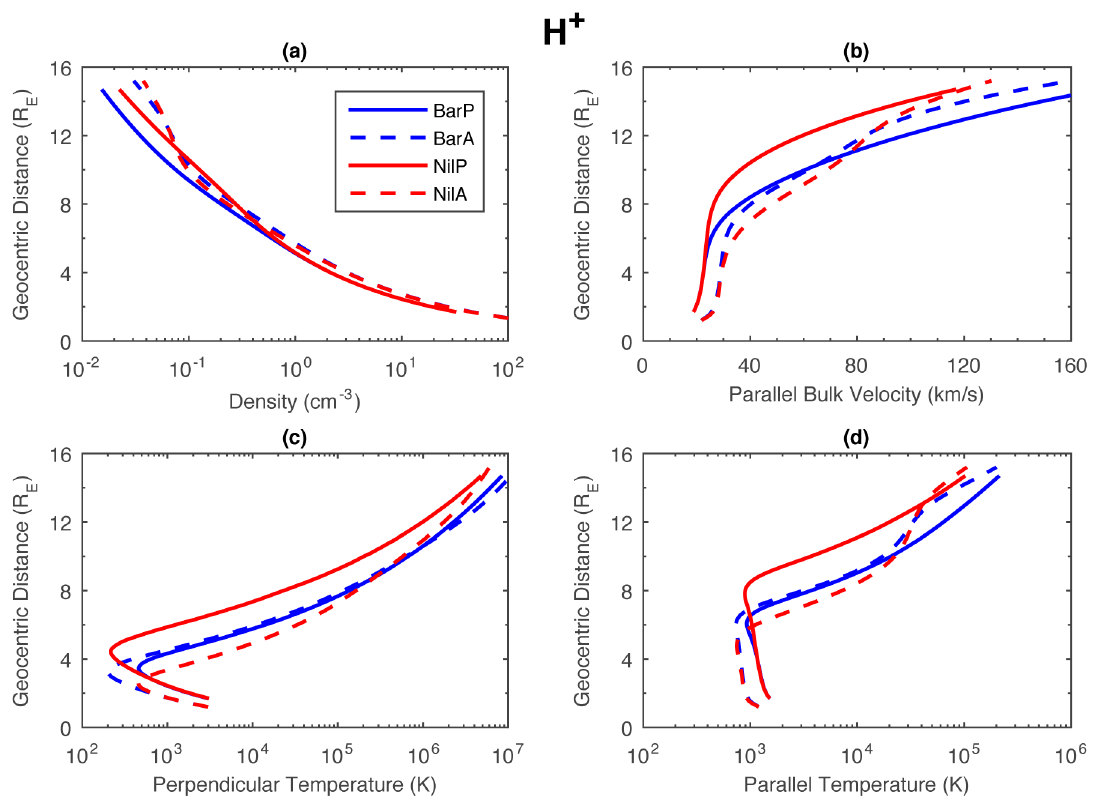
Figure 4. H + (a) density (b) parallel bulk velocity (c) perpendicular temperature and (d) parallel temperature